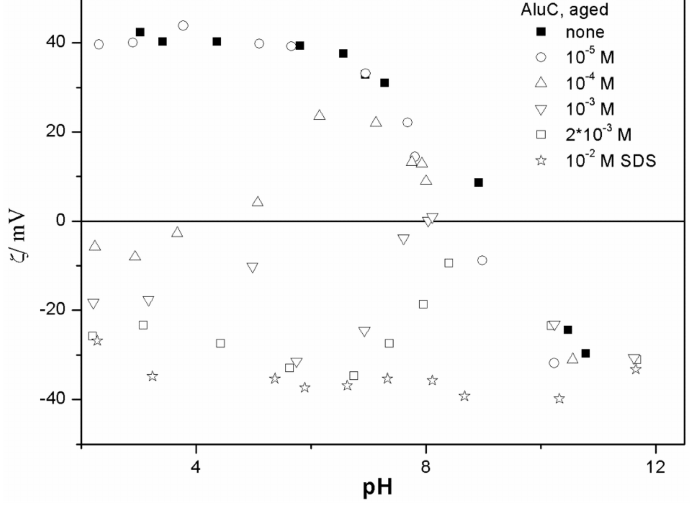
Figure 6. The ζ potential of alumina in aged dispersions in the presence of sodium